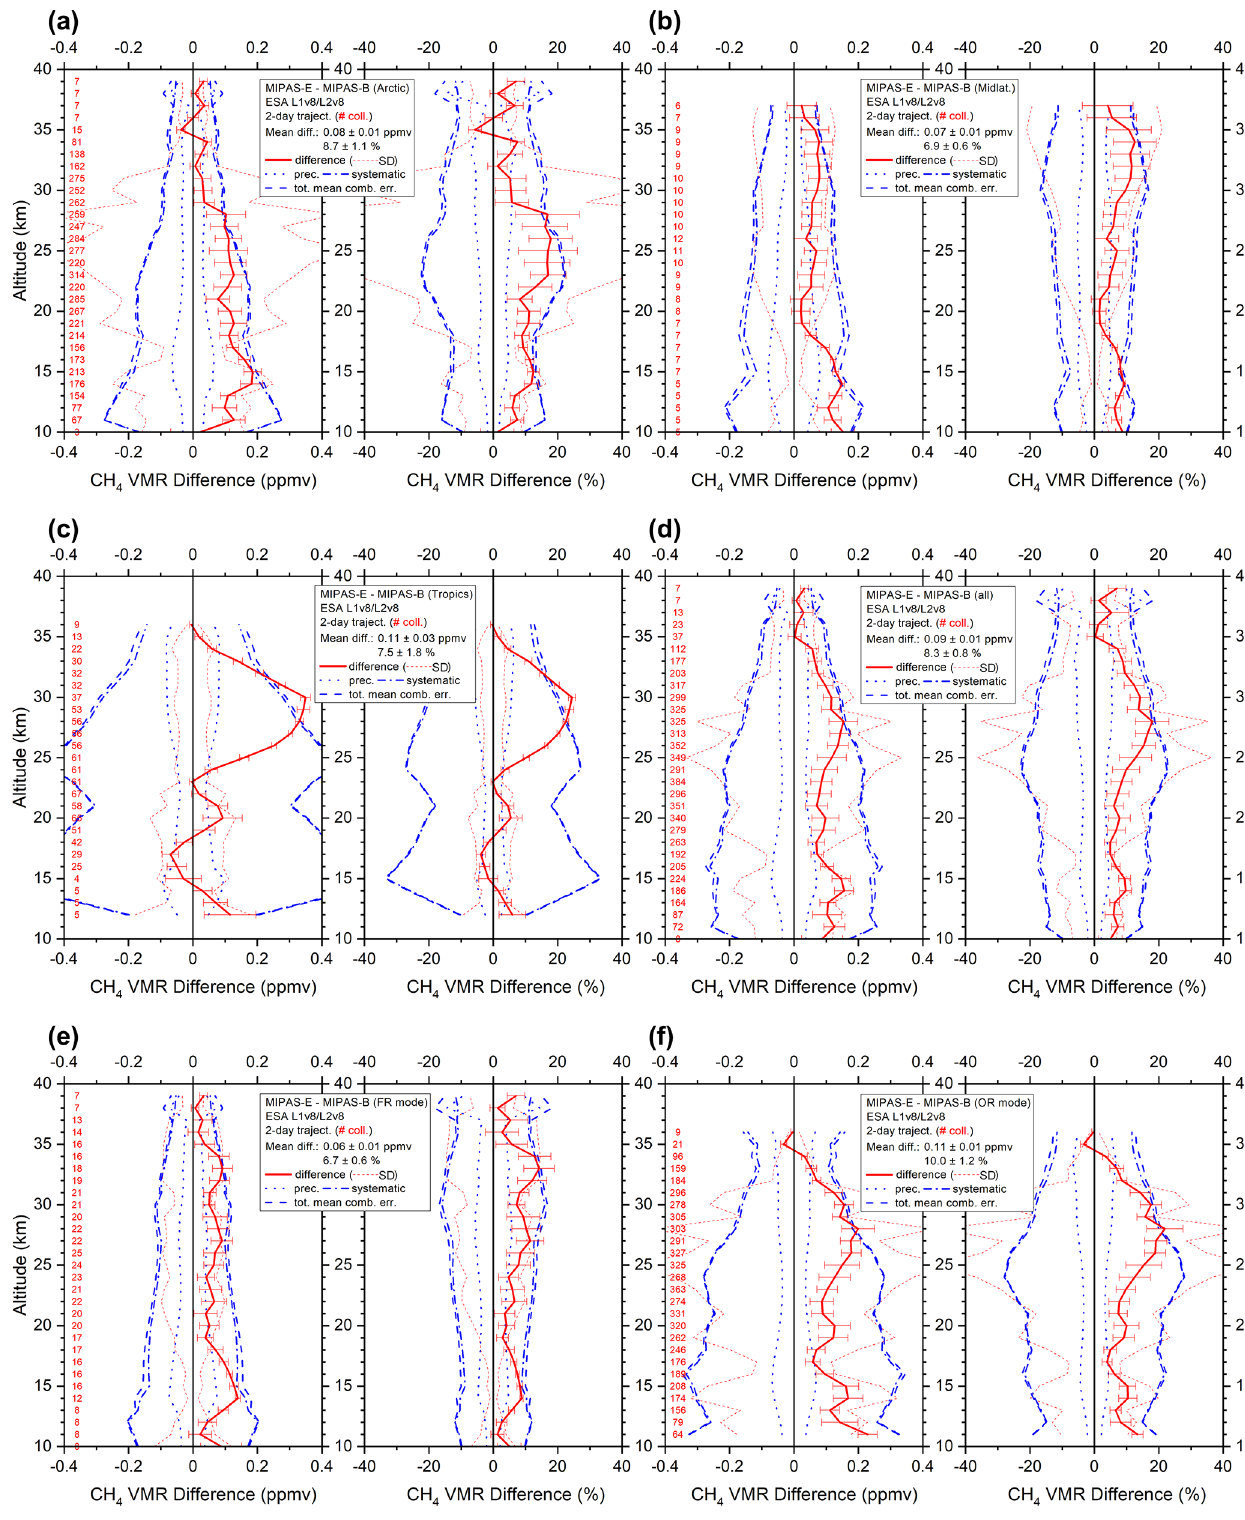
Figure 6. Same as Fig. 3 but for CH 4